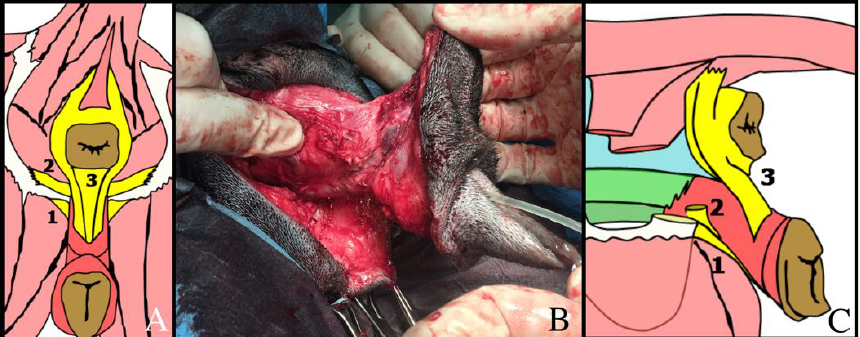
Figure 3. Caudal ( A ) and lateral ( C ) schematic presentation of the perineal muscles: (1) ischiocaver- nosus muscle; (2) ischiourethralis muscle; (3) vestibular muscle. ( B ) Intraoperative image of the lat- eral view of vulva and vestibule after the resection of the ischiocavernosus and ischiourethralis